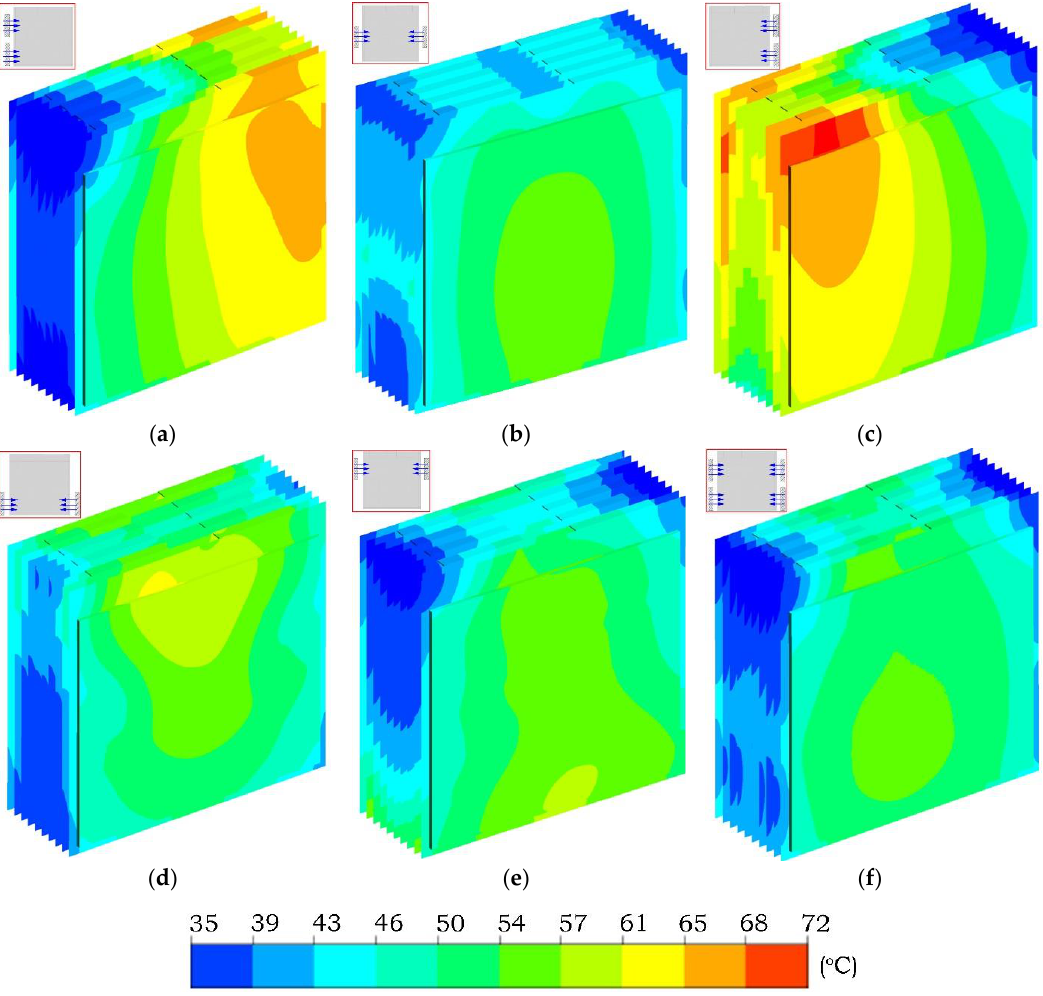
Figure 7. Temperature distribution of the battery module after 5C discharging at an rpm of 2000: ( a ) D1—two fans on the left, ( b ) D2—two fans in the middle, ( c ) D3—two fans on the right, ( d ) D4—two fans on the bottom, ( e ) D5—two fans on the top, and ( f ) D6—four fans.